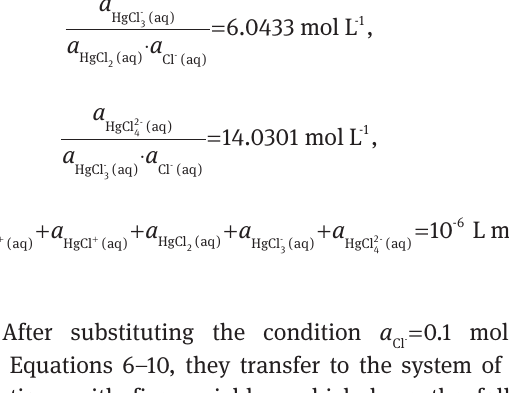
Figure 2: The potential-pH diagram of Cl - -H and 1